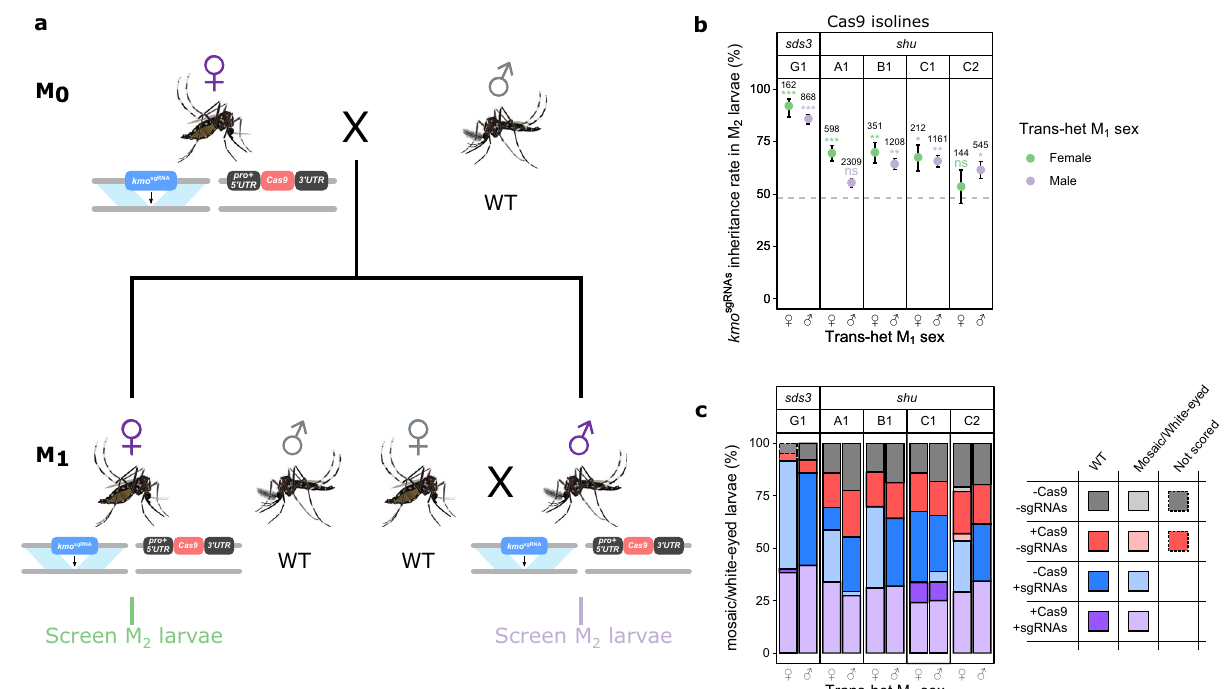
Fig.2|Inheritancebiasofthe kmo sgRNAs elementcouldstilloccurwithmaternal depositionofCas9and/orsgRNAs.a CrossingschemefordeterminationofCas9- induced inheritance bias. b Inheritance rate of the kmo sgRNAs in P 2 larvae, scored by AmCyan fl uorescence. Total number of screened larvae from each cross is pre- sented above corresponding data points. Error bars are the Wilson con fi dence intervals forthe binomialproportion.The con fi denceintervalsare calculatedfrom the pooled progeny count and cannot account for potential over dispersal due to